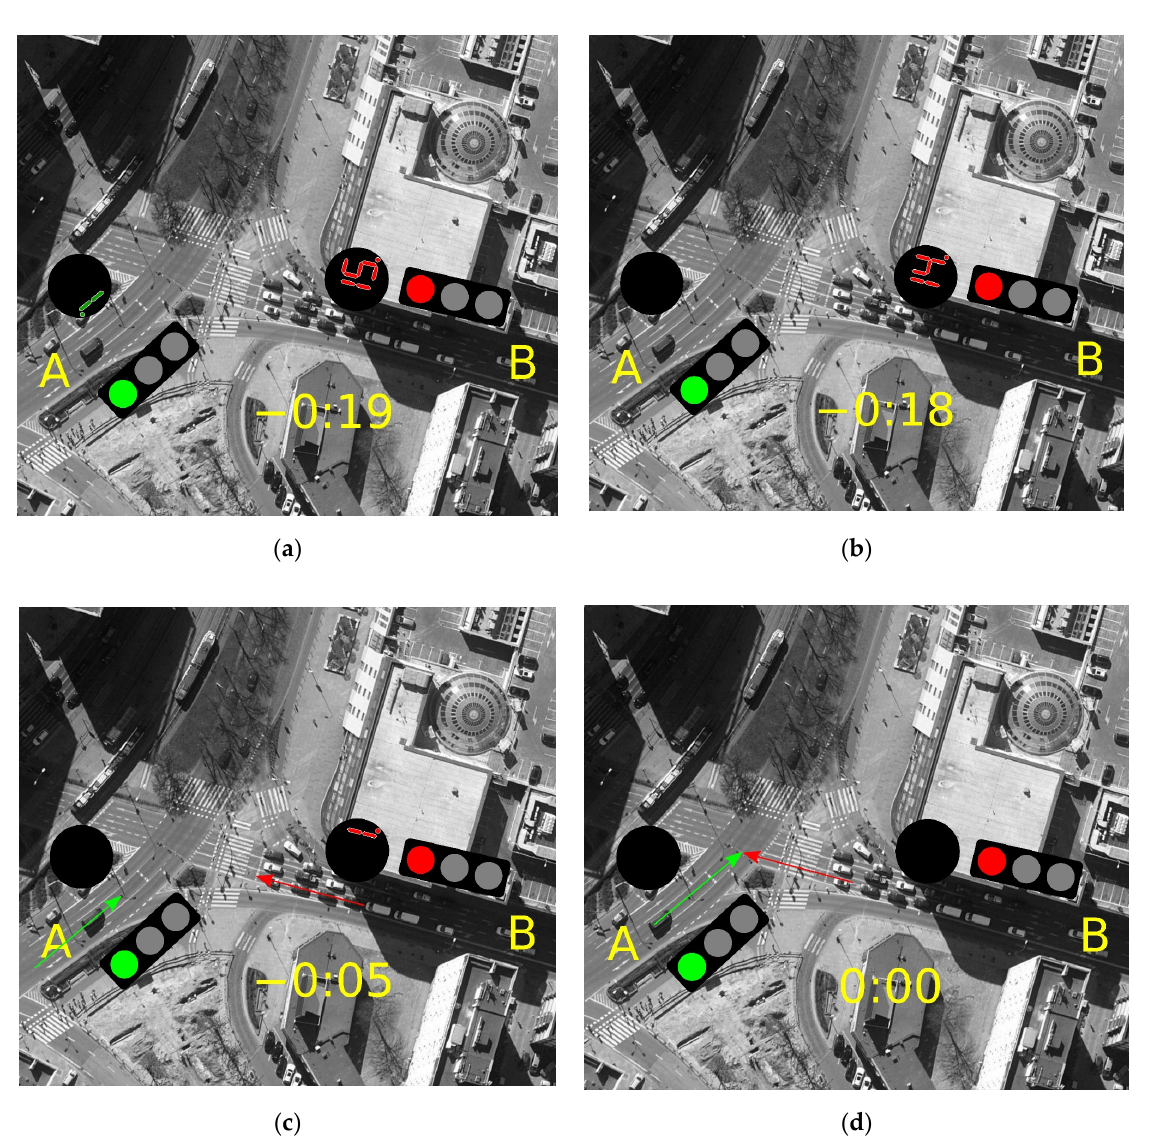
Figure 12. Sequence of events related to the crash: ( a ) GSCT and RSCT at intersection approaches; ( b ) extinction of GSCT at approach A; ( c ) extinction of RSCT at approach B, early start of vehicles at approach B; ( d ) road accident. (Background map Main Office of Geodesy and Cartography).